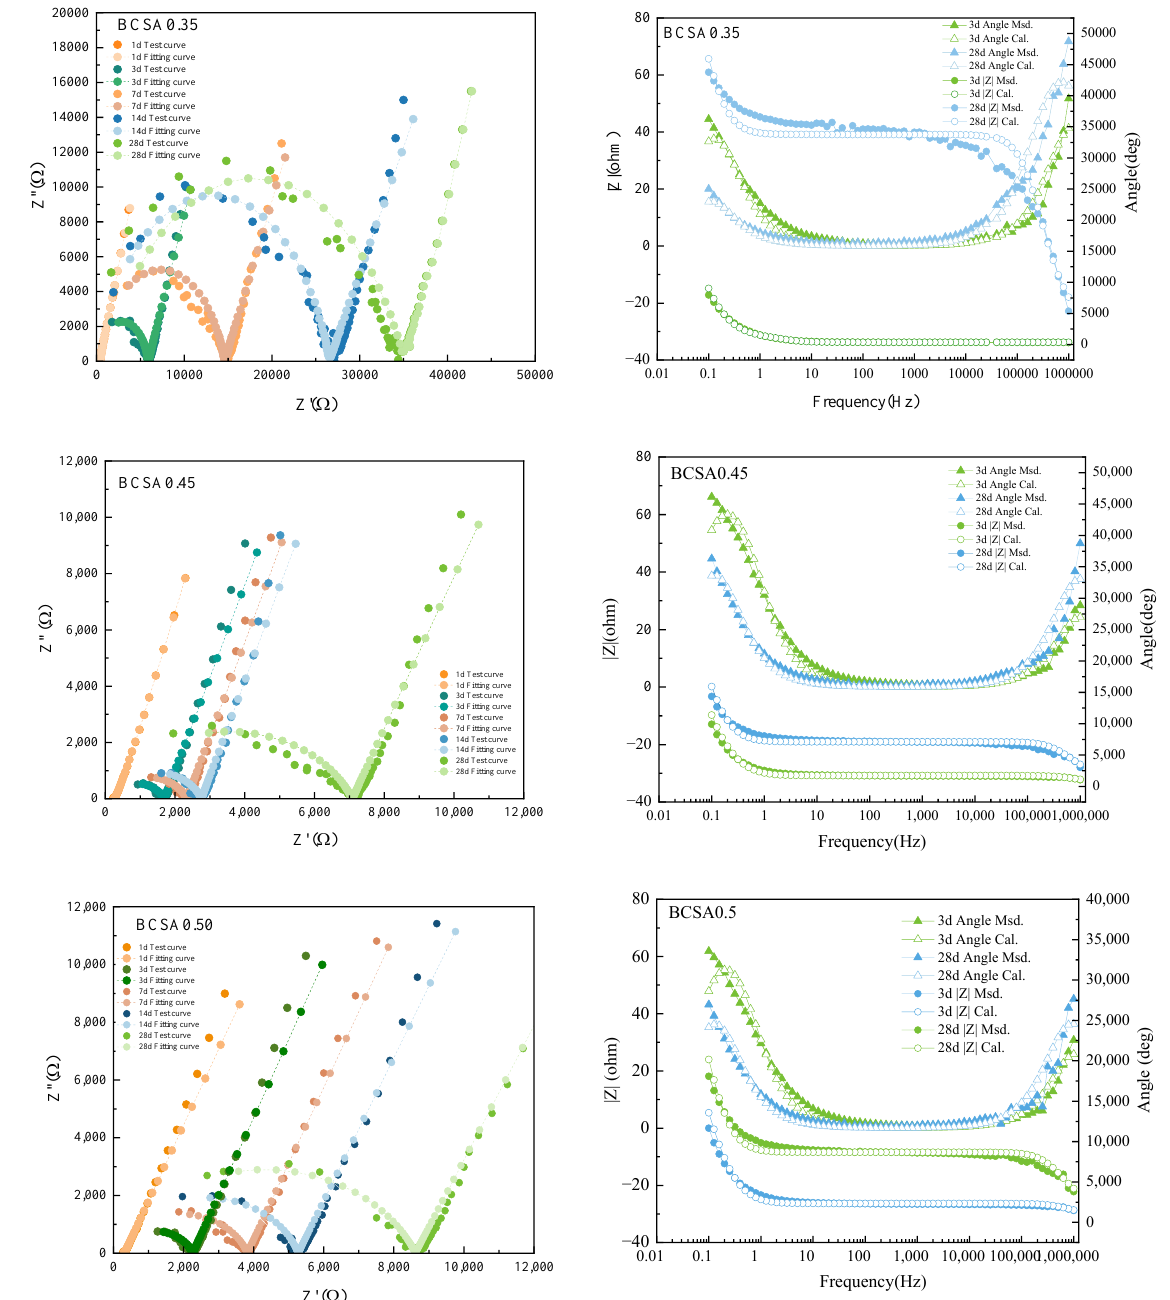
Figure 6. Nyquist and Bode curves and fitting curves of BCSA0.35, 0.45 and 0.50 at 1 d, 3 d, 7 d, 14 d, and 28 d.